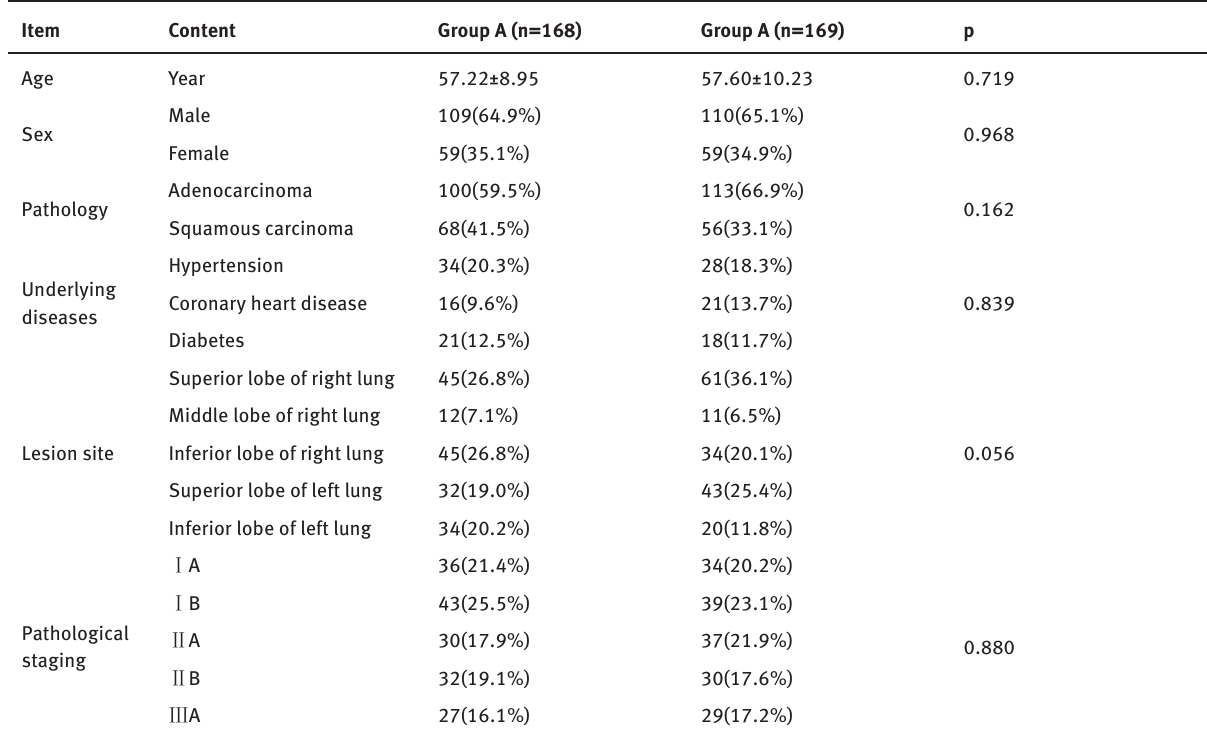
Table 2: Comparison of the patients’ general